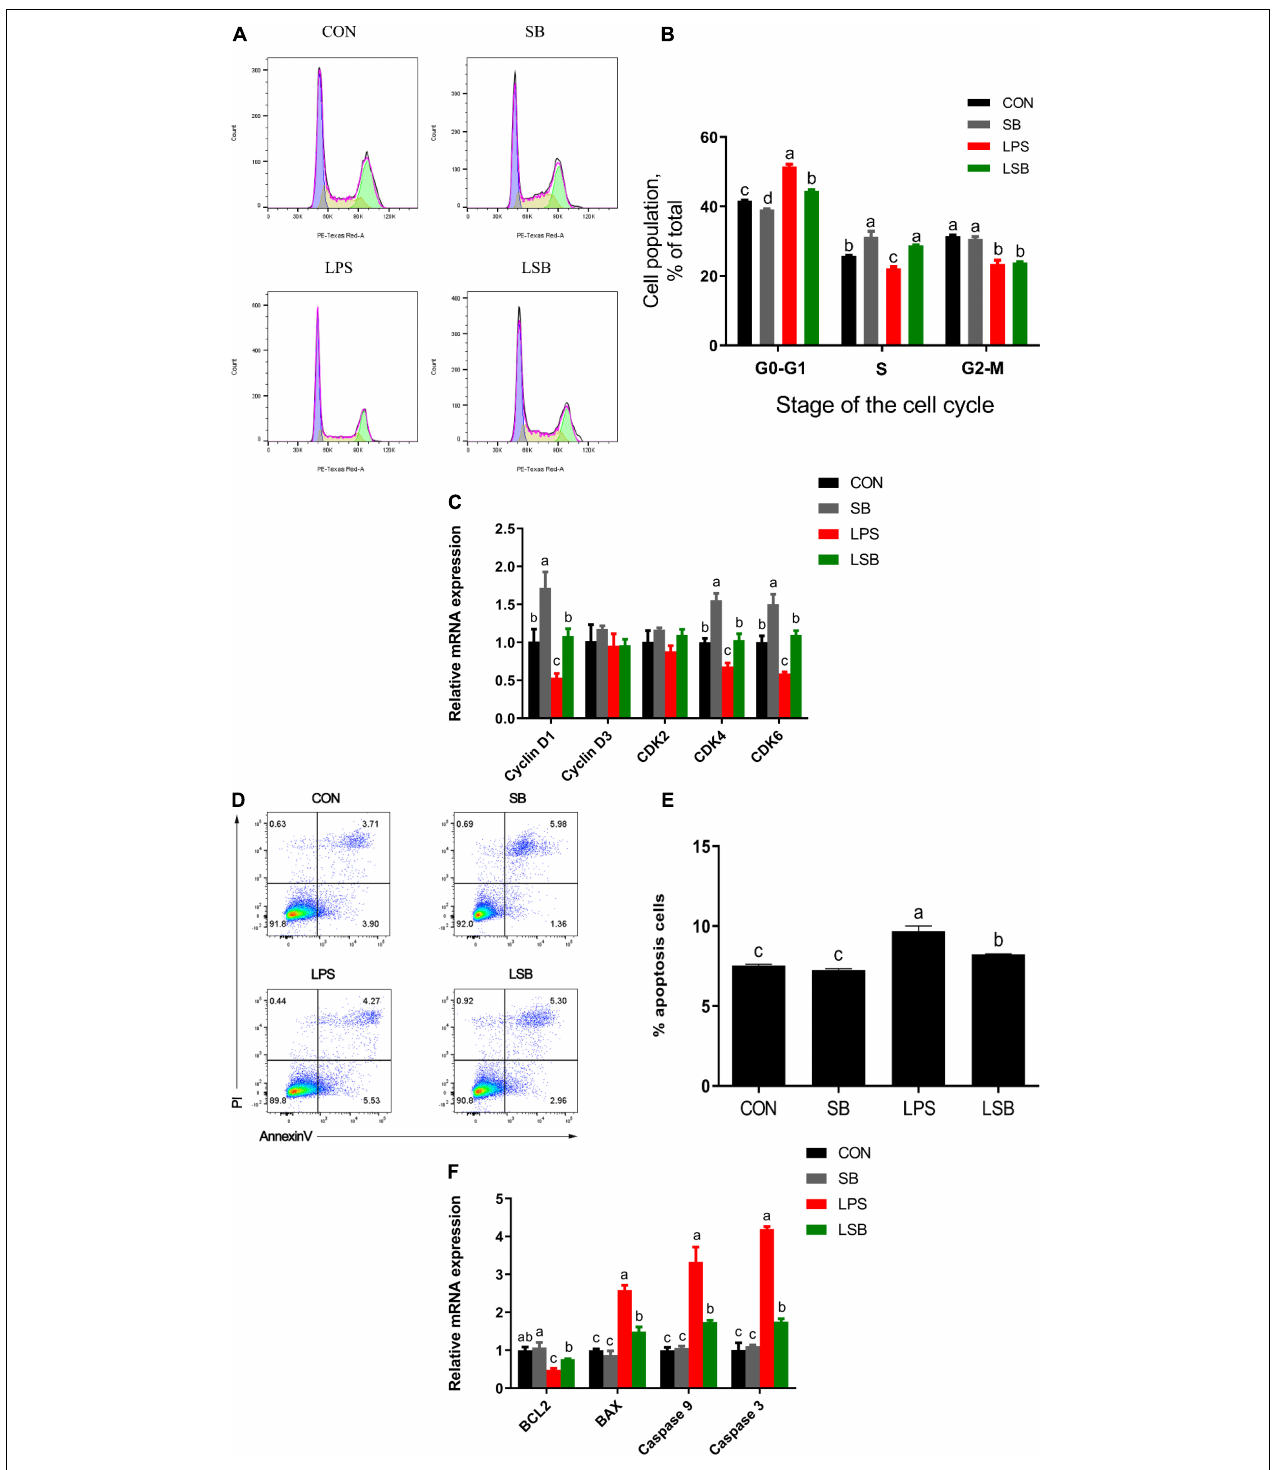
FIGURE 4 | Effect of SB on proliferation and apoptosis in BRECs stimulated with LPS. BRECs were pretreat with SB (0.5 mM) for 18 h followed by stimulation with LPS for 6 h. After incubation, cells were analyzed by flow cytometry and qRT-PCR. (A) A representative histogram of flow cytometric analyses. (B) Percentages of cells at different phases of the cell cycle. (C) Gene expression of Cyclin D1, Cyclin D3, CDK 2, CDK 4, and CDK6. (D) Absorbance of FITC-A; absorbance of fluorescein isothiocyanate-Annexin V. (E) Apoptosis percentages in cultures exposed to LPS or SB. (F) Gene expression of Caspase 3, Caspase 9, Bcl-2, and BAX. The values are shown as mean ± SEM ( n = 3). The letters in superscript indicate that the difference between groups was significant ( P < 0.05).